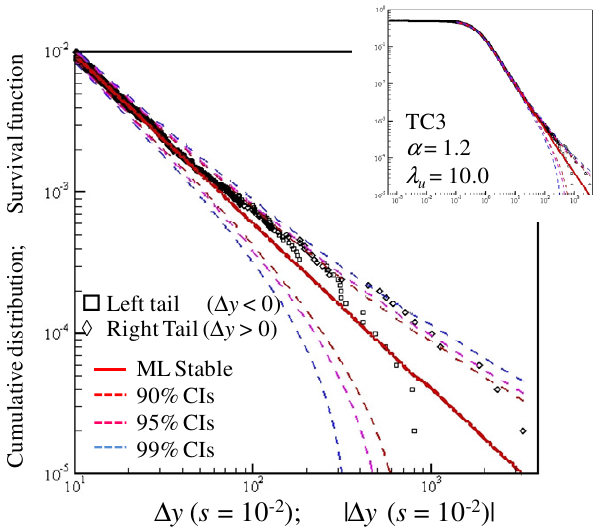
Fig. 4. Cumulative distribution versus | 1y | for 1y < 0 and survival function versus 1y for 1y > 0 of TC3 at s = 10 − 2 . Main figure emphasizes behaviour at tails. Solid curves represent ML fitted sta- ble distribution; dashed curves indicate confidence intervals, CIs.